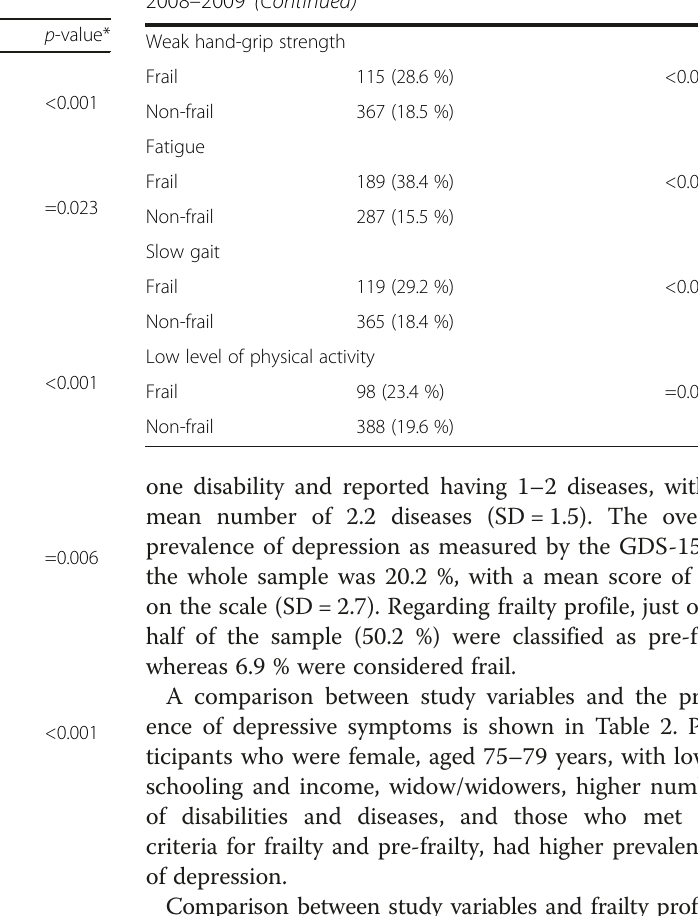
Table 2 Sample description according to prevalence of depressive symptoms ( n = 2402). FIBRA Unicamp, Elderly,